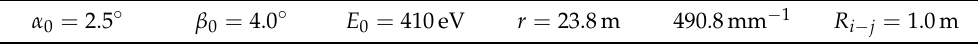
Table 2. Design parameters of RZP 1,2 inside the TDCM, according to Figure 1 with index ( i , j ) (cid:101) { 1,2 } . α 0 = 2.5